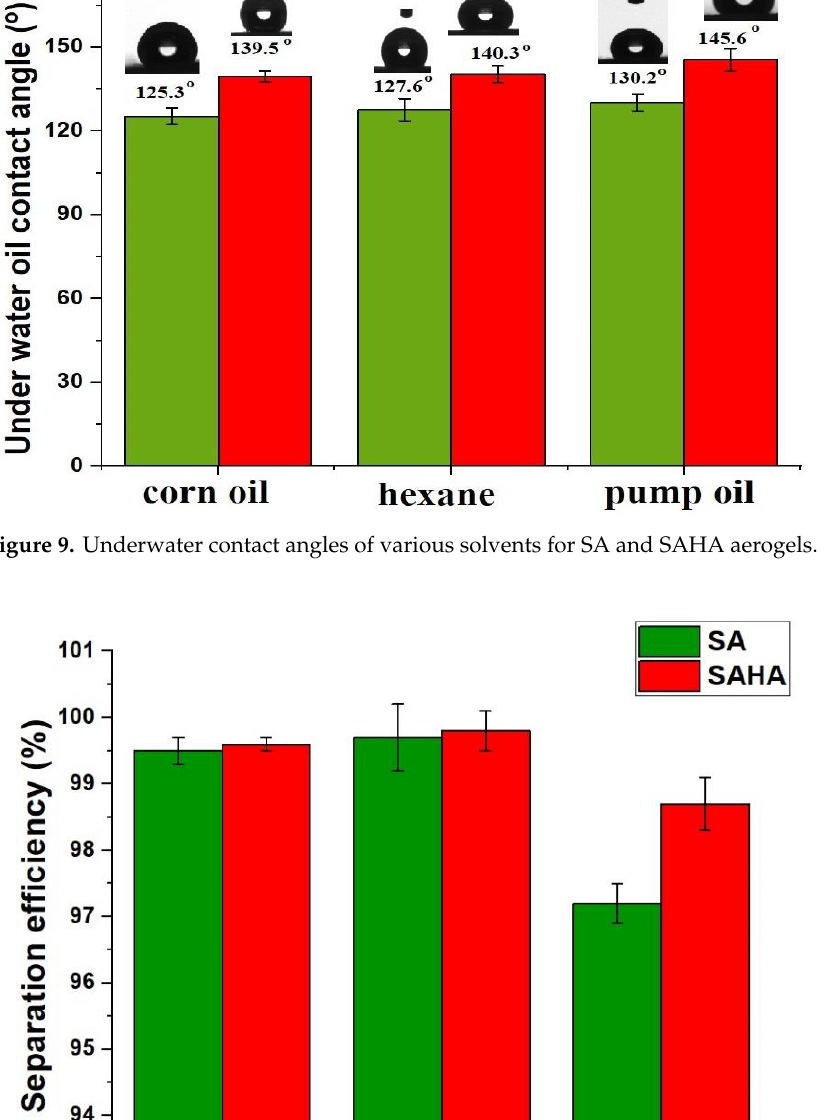
SA SAHA Figure 11. Separation efficiency versus recycle numbers (corn oil/water mixture as sewage).